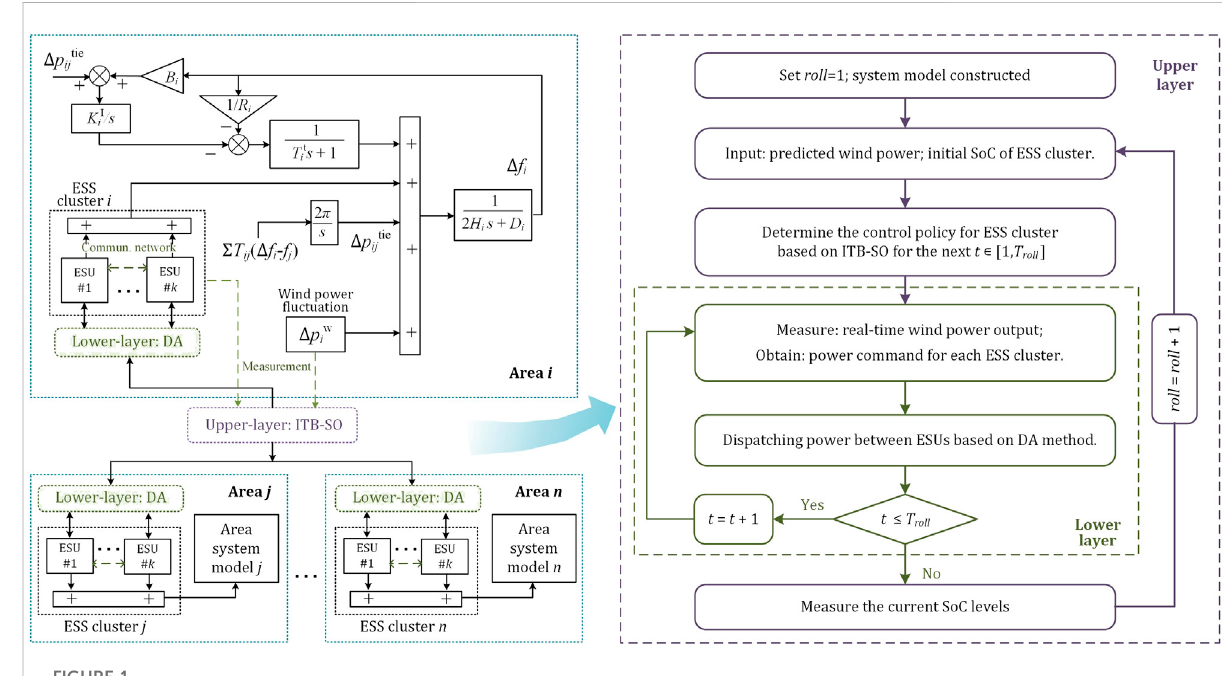
FIGURE 1 Framework of bi-layer secondary frequency control for energy storage clusters in multi-area